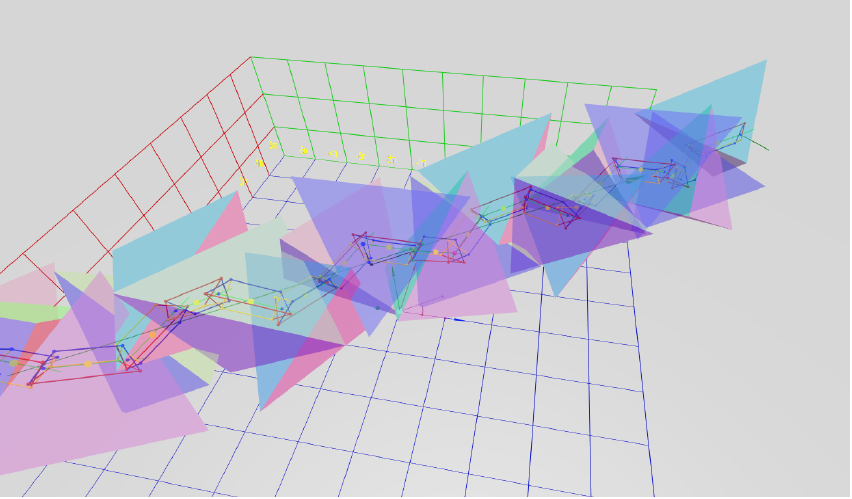
Figure 12. A Period-7 Tetrahelix generated with a twist of 80.43 ◦